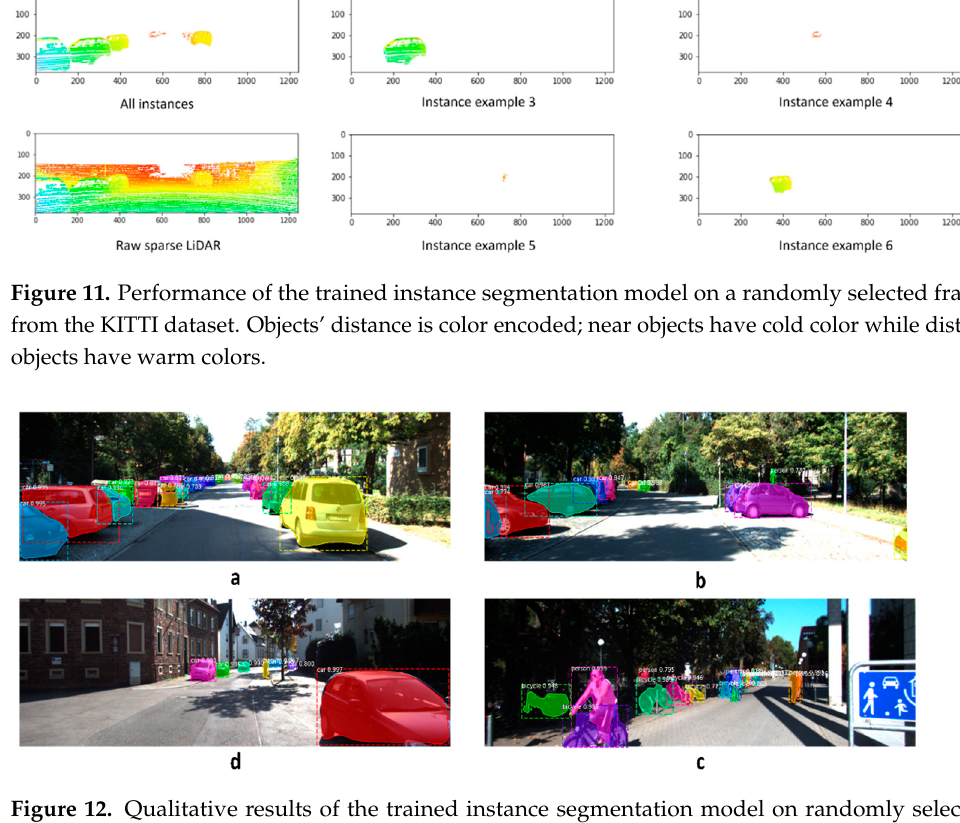
Figure 12. Qualitative results of the trained instance segmentation model on randomly selected frames from the KITTI dataset. ( a , b ) show the performance in a crowded vehicle scene, ( c ) shows the performance when objects are very far, and ( d ) shows the performance in a cyclists’ crowded scene.